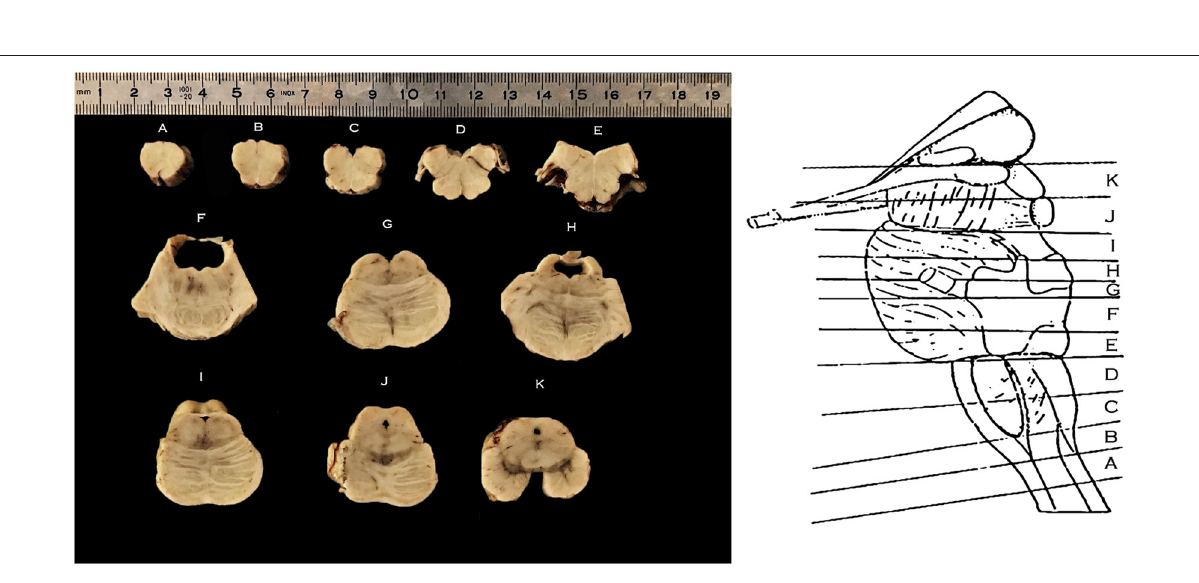
Frontiers in Neuroanatomy |